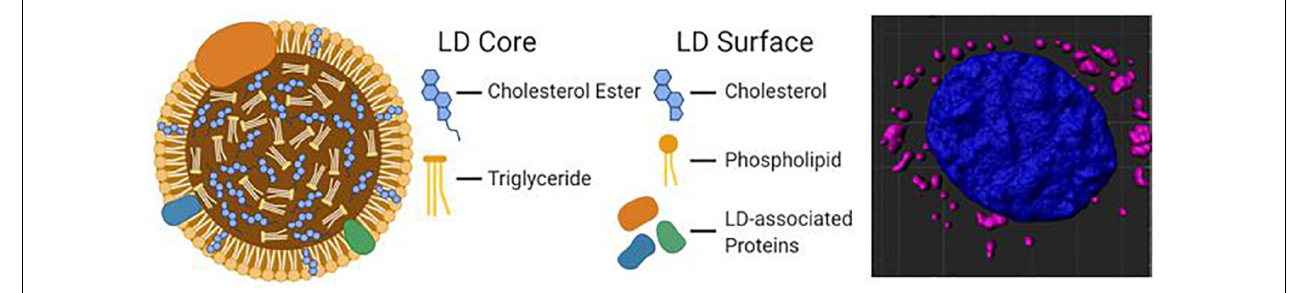
FIGURE 1 | A diagram of the molecular structure of a standard lipid droplet (LD) along with a software reconstruction of a microscopic image of astrocytes in vitro containing lipid droplets (highlighted in pink; LipidSpot) surrounding a nucleus (in blue; DAPI).